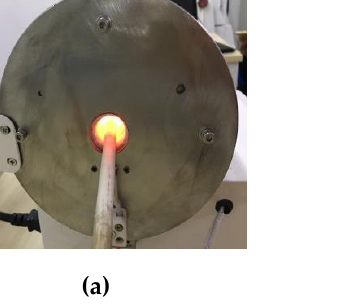
Figure 10. Test rig at 1100 ◦ C; ( a ) sensor position; ( b ) inside the heater.